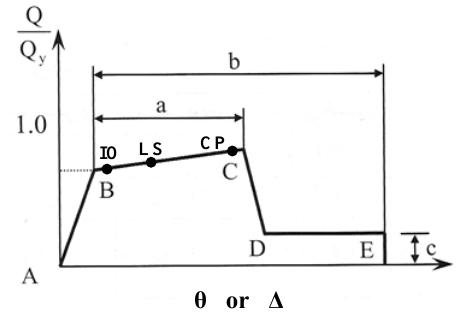
Fig. 3. Load-deflection model of members